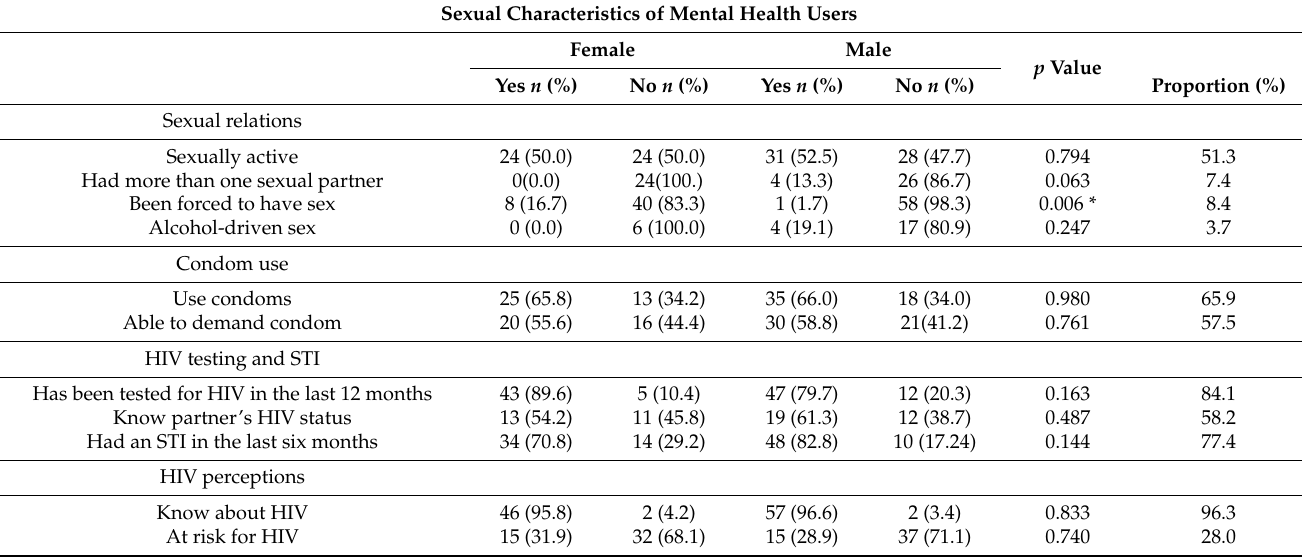
Table 2. Sexual characteristics of mental health care